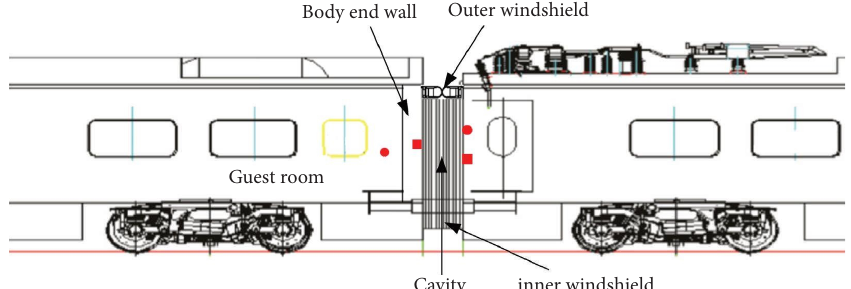
Figure 1: Schematic diagram of the layout of the car body end wall area (the circle represents the noise measuring point, and the square represents the vibration measuring point).